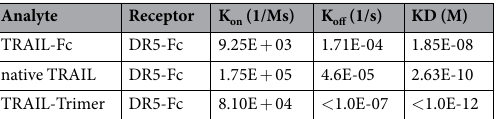
cell line had grown to an average size of ~270 mm 3 , mice were randomized (n = 6/group), and TRAIL-Trimer doses of 30 mg/kg, 50 mg/kg or 80 mg/kg were given intravenously once-daily over the first 5 days of the study. Tumor sizes rapidly decreased following TRAIL-Trimer administration in a dose-dependent fashion (Fig. 6a). In contrast, tumors from mice that had been administered with formulation buffer (negative control) grew rapidly and continuously. The dose-response of TRAIL-Trimer observed here suggests that the best antitumor activity with this regimen is achieved with 80 mg/kg/day, where the longest sustained antitumor response was observed. Thus, we then compared the efficacy of TRAIL-Trimer (80 mg/kg/day) to an equimolar dose of native TRAIL (30 mg/kg/day), given the approximately 2.7 fold difference in molecular weight between the two proteins. At every time point that tumor sizes were measured following dosing, tumors in mice treated with TRAIL-Trimer were smaller than in mice treated with native TRAIL (Fig. 6b), demonstrating that TRAIL-Trimer antitumor activity in vivo is superior